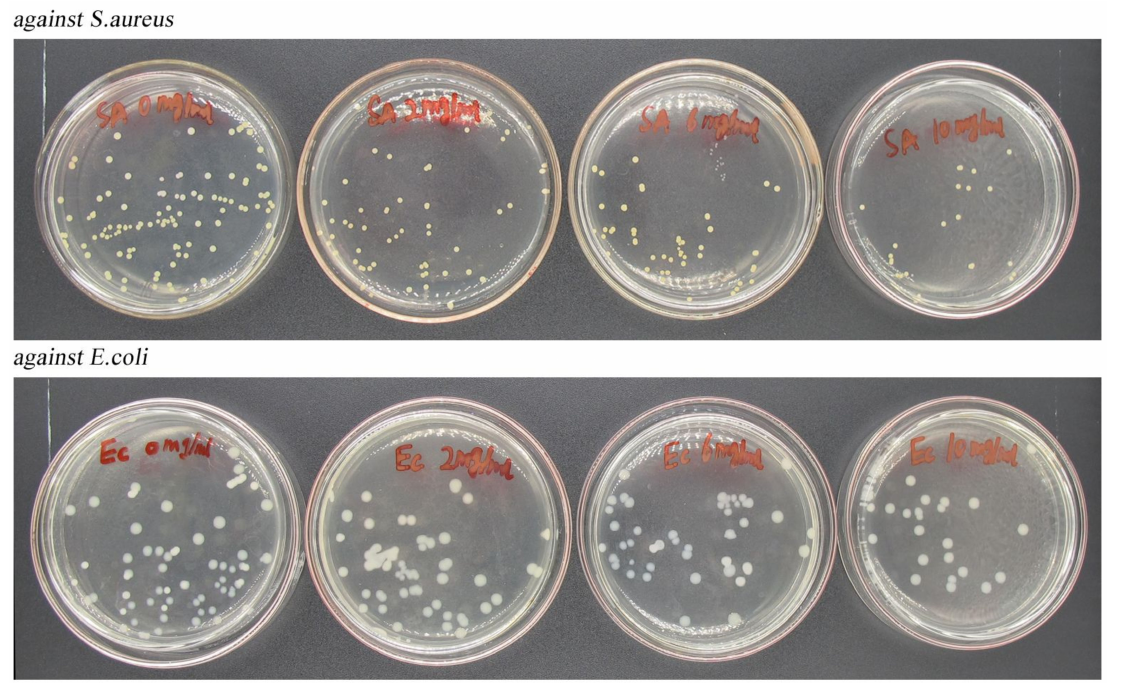
Figure 13. Antibacterial efficiency of CA-loaded composite nanoparticles against S. aureus and E. coli (from left to right, the mass concentration of nanoparticles is 0%, 2%, 6%, and 10%).